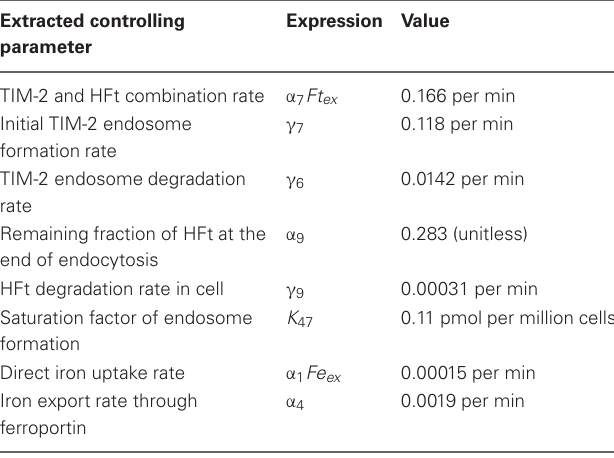
vector and TIM-2 containing cells through Tf. Biotin labeled apo-